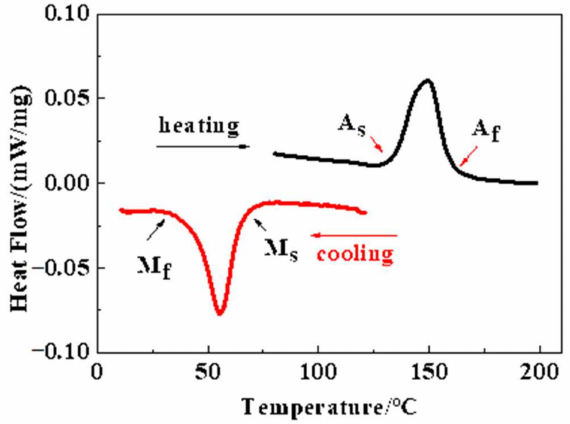
Figure 1. DSC curves and phase transformation point of Fe-22Mn-12Cr-4Co alloy.